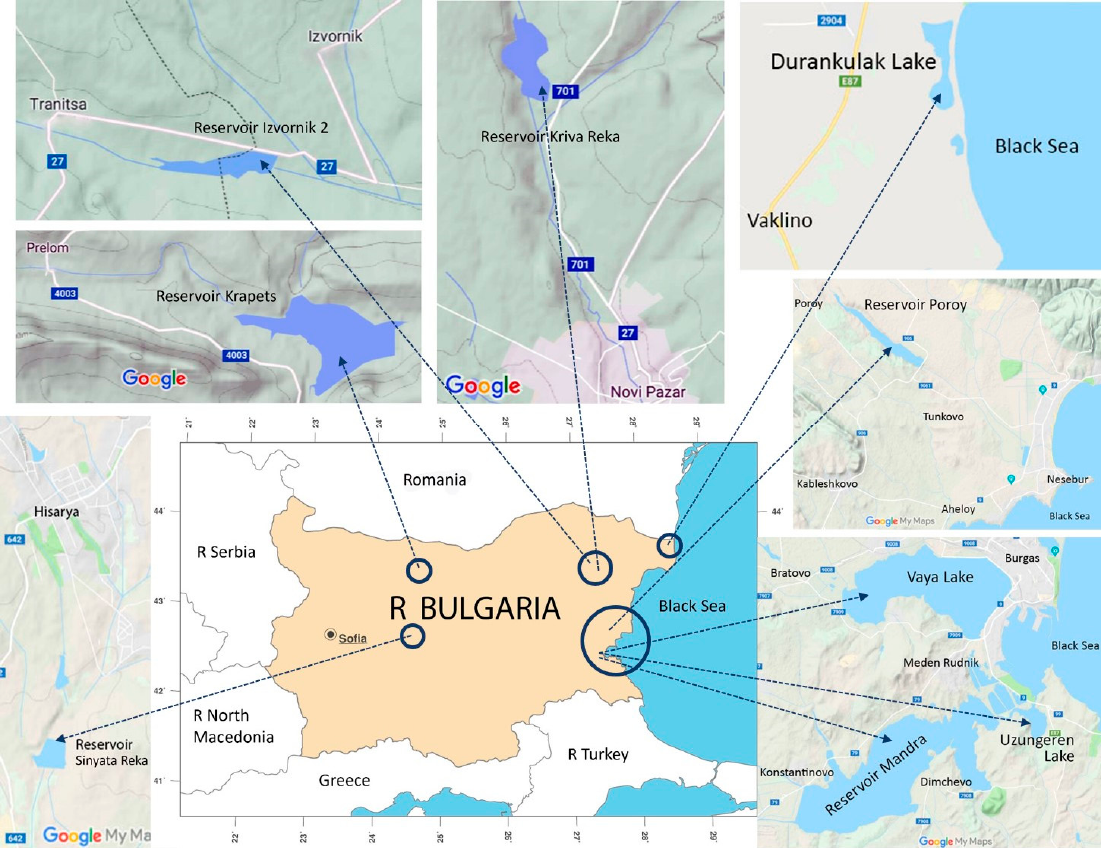
Figure 1. Map of R. Bulgaria with indication of the studied waterbodies (modified after (http://www.ginkgomaps.com and Google Maps). Explanations are provided in the text.